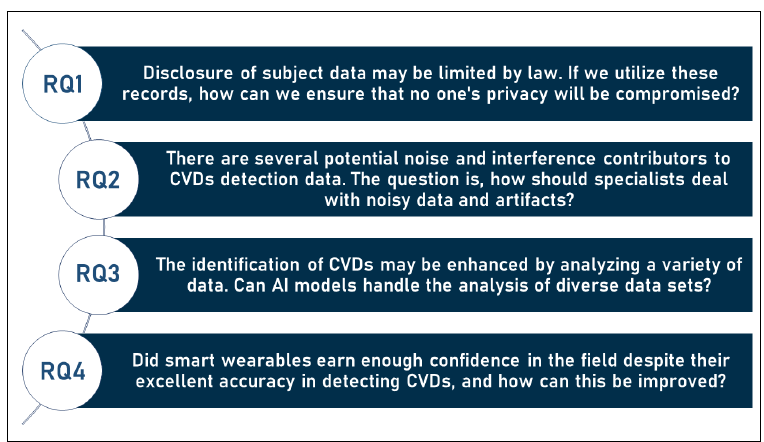
Figure 10. Research questions arising from analysing usage of wearables in CVDs